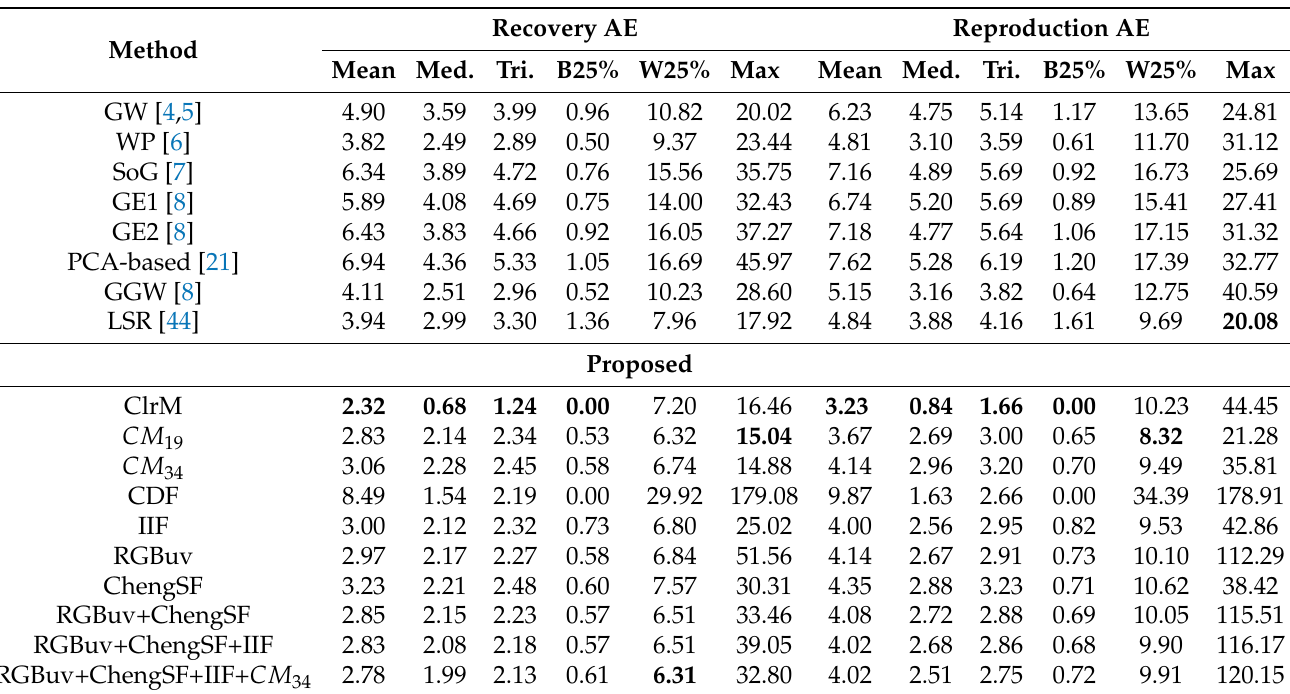
Table 3. Comparative performance metrics between the proposed method and some conventional methods for Canon